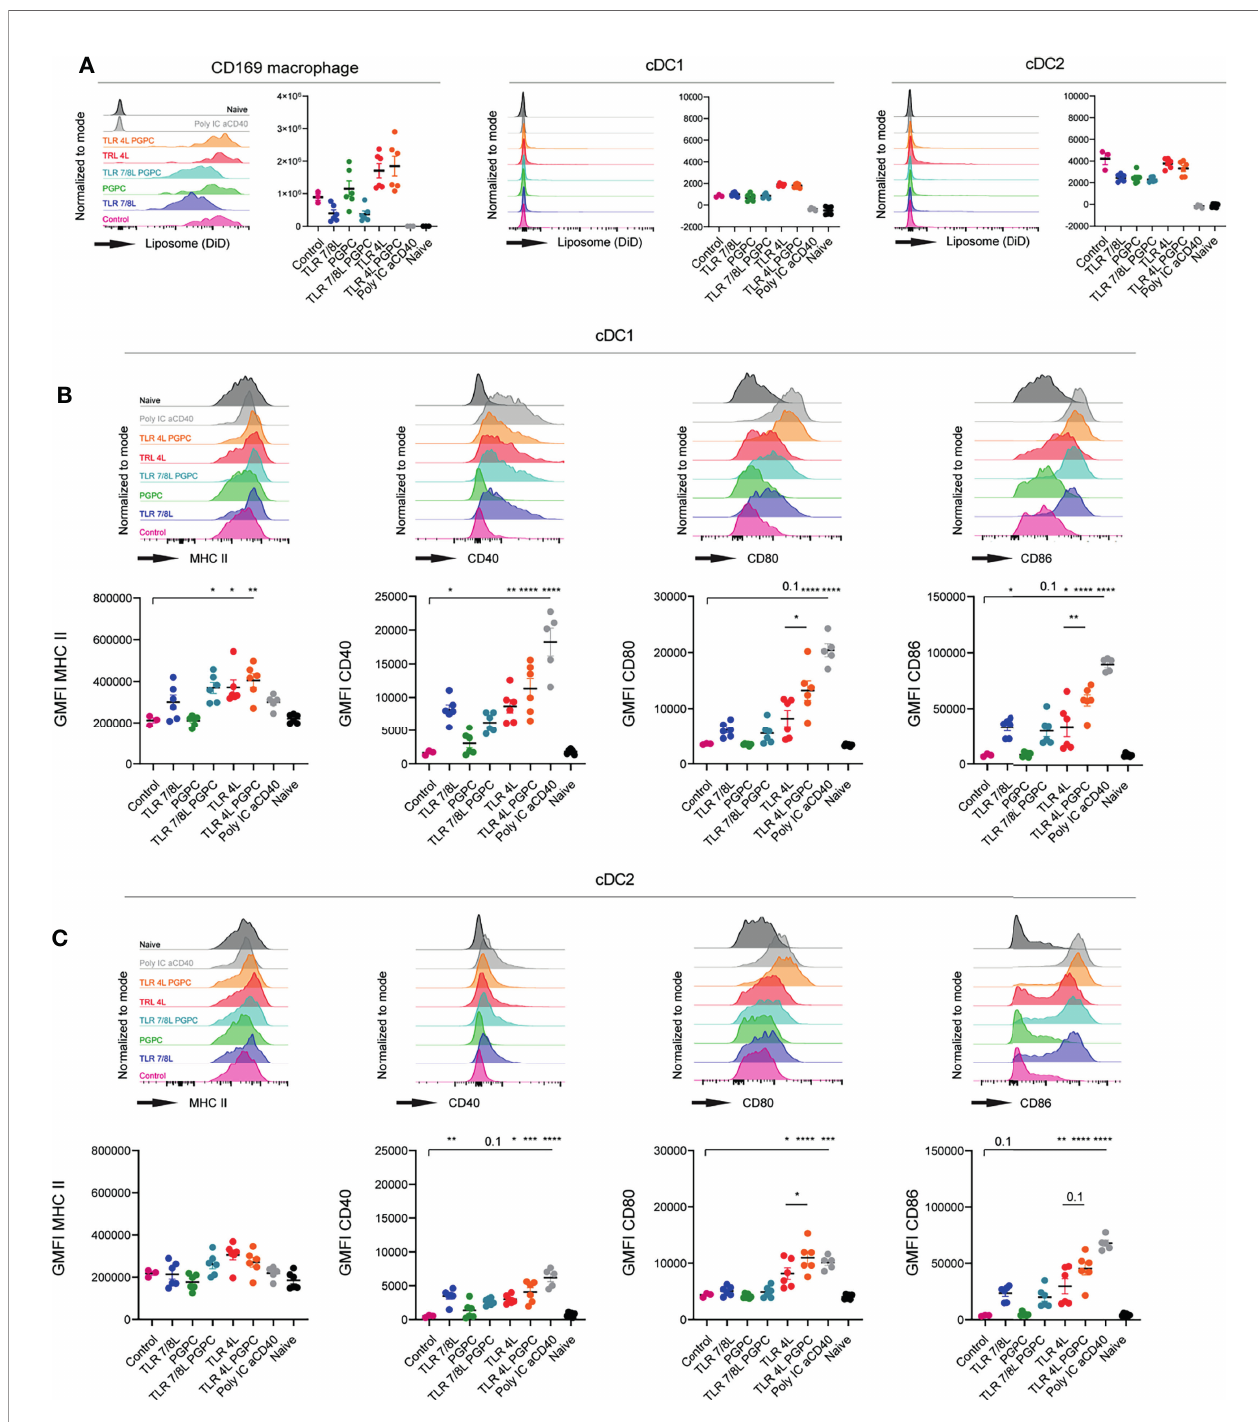
FIGURE 2 | TLRL-containing GM3 liposomes induce DC maturation in vivo , but additional incorporation of PGPC has minor effects. (A – C) Mice were i.v. injected with different liposomal formulations, poly IC and aCD40 antibody as positive control, or left uninjected (naive). 16h after injection, spleens were collected and a single cell suspension was used for fl ow cytometry staining and analysis. Indicated are representative histograms and the quanti fi ed DiD-signal as average ± SEM, [ n = 6 ( n = 3 for control liposome)], data pooled from two independent experiments (A) . Indicated are representative histogram overlays and quanti fi ed average ± SEM of maturation markers on cDC1 and cDC2 [ (B, C) , respectively) [ n = 6 ( n = 3 for control liposome)], data pooled from two independent experiments. *p < 0.05, **p <0.01, ***p < 0.005 and ****p <